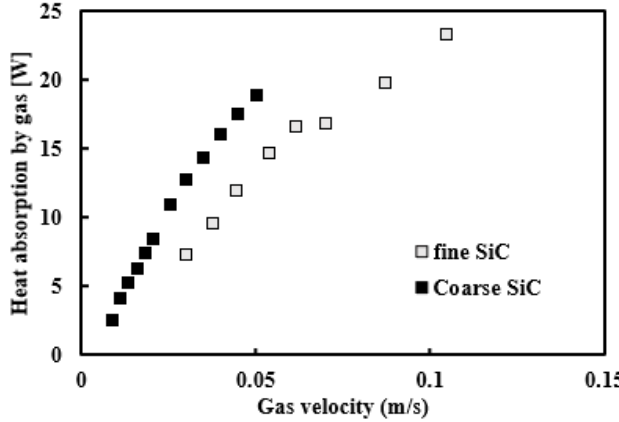
Figure 6. E ff ect of gas velocity on heat absorption by gas in particle receiver with di ff erent Figure 6. Effect of gas velocity on heat absorption by gas in particle receiver with different SiC.